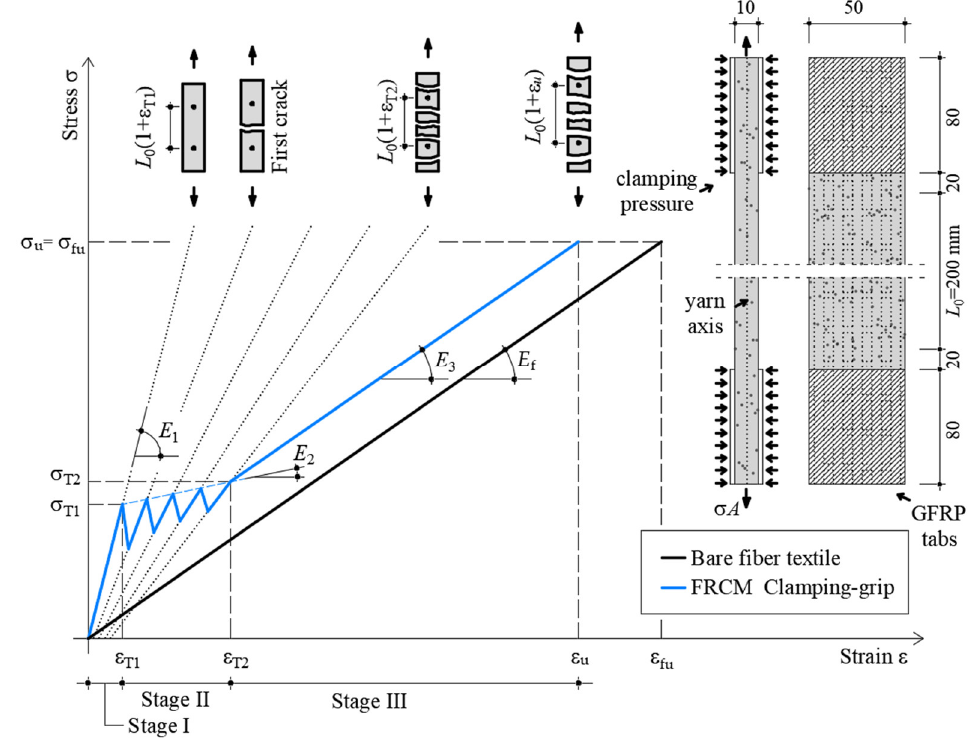
Figure 1. Idealized stress–strain response of quasi-static tensile test of FRCM coupons (dimensions in mm).